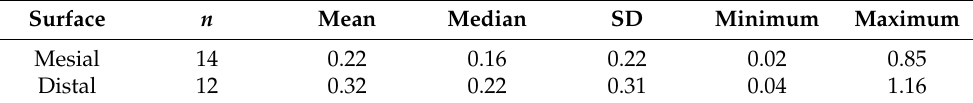
Table 2. Descriptive analysis of the volume (mm 3 ) of the enamel removed after the interproximal enamel reduction procedure at the mesial and distal interproximal enamel surfaces of the STL digital files.